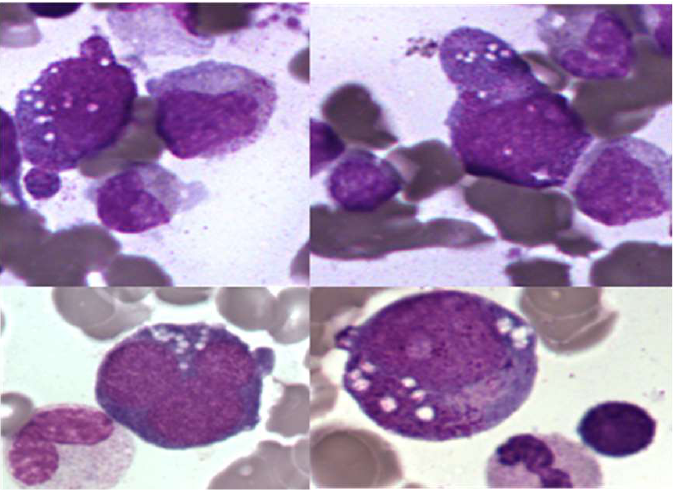
Figure 2. Cytoplasmic vacuolation of granular and erythroid progenitor cells, ×100. From a functional point of view, the UBA1 gene codes for the enzyme UBA1 or Enzyme E1, are involved in the initiation of the protein ubiquitylation process. This post- translational modification is essential in the regulation of protein turnover, especially those involved in the cell cycle, cell death, signal transduction, etc., by allowing them to be sent to the proteasome, a protein degradation organelle. Ubiquitylation is also involved in non-proteolytic functions: assembly of multiprotein complexes, intracellular signaling, inflammatory signaling, DNA repair, autophagy process, etc. [15]. Given its pleiotropic function, it is expected that functional alteration of E1 causes clinical heterogeneity in VEXAS patients. The binding of ubiquitin to lysine residues of target proteins is enabled by the sequential action of three enzymes: E1 (ubiquitin activating enzyme), E2 (conjugating enzyme) and E3 (ligase enzyme). In contrast to the E1 enzyme, which is mainly encoded by UBA1, there are dozens of distinct E2 conjugating enzymes and hundreds of E3 ligase enzymes that ensure the specificity of ubiquitylation. E1 forms a thioester bond with the terminal region of ubiquitin through an ATP-dependent mechanism. The ubiquitin is then transferred to a sulfide group of a conjugating enzyme E2. Finally, E3 binds the ubiquitin molecule to a lysine of the target protein. The anchoring of at least four ubiquitin molecules to the target protein is necessary for it to address the proteasome. Different models of ubiquitylation exist (mono-ubiquitylation, multi-ubiquitylation or poly-ubiquitylation) and are distinguished according to the number of ubiquitin binding sites on the protein to be degraded and the type of binding (linear or polymeric) [15]. Physiologically, UBA1 encodes two protein isoforms: UBA1a for nuclear localization, translated at methionine 1 (exon 2), and UBA1b for cytoplasmic localization, a shorter isoform since its translation is initiated at methionine 41 (M41) (exon 3) [1]. Beck et al.